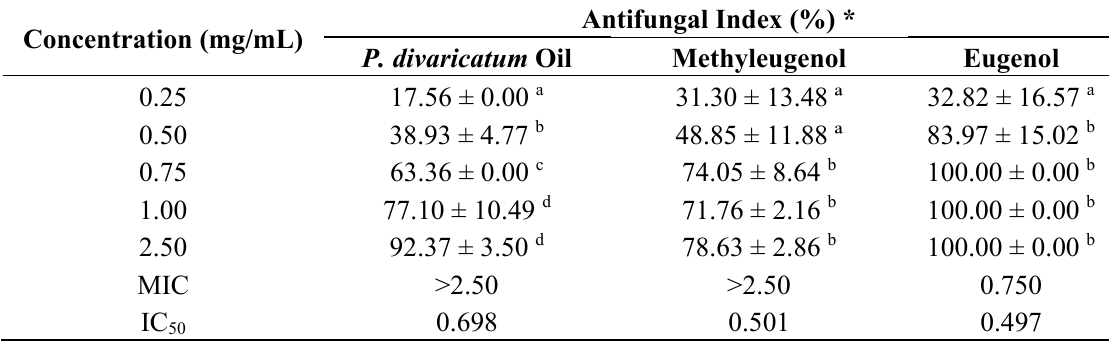
Table 2. Antifungal activity of the oil of P. divaricatum and the standards of eugenol and methyleugenol against F. solani f. sp. piperis